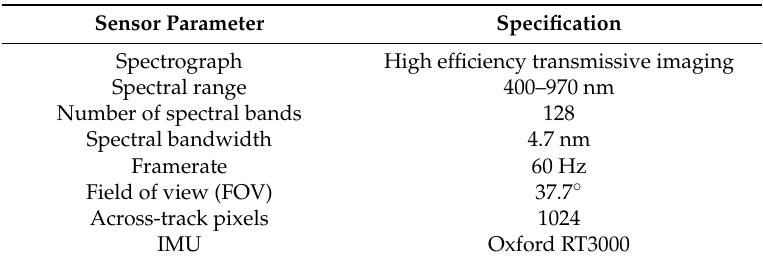
Table 2. Sensor specifications and configuration during